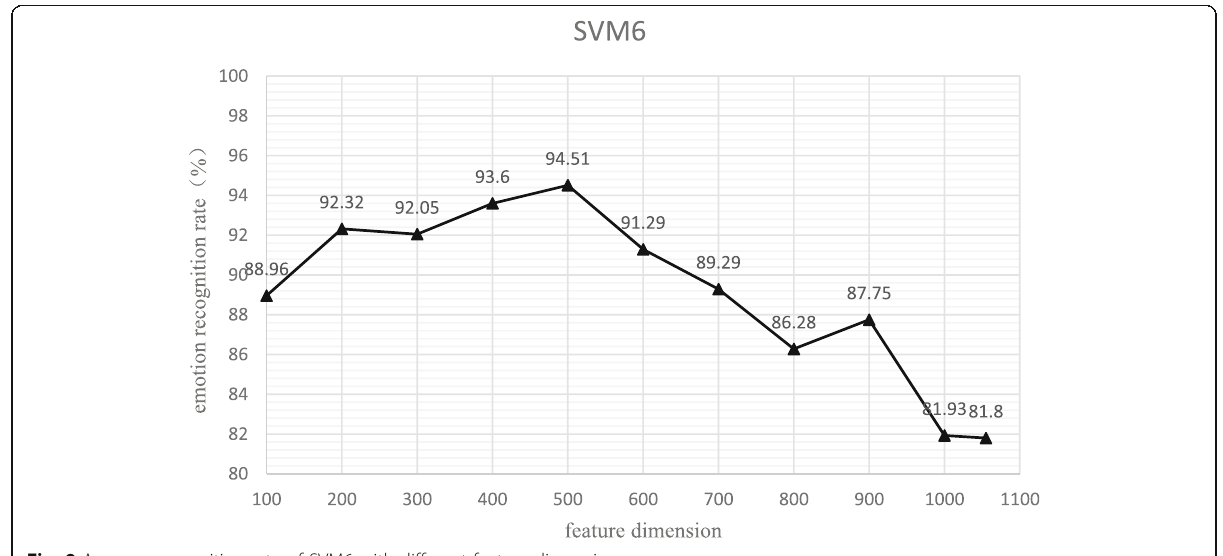
Fig. 9 Average recognition rate of SVM6 with different feature dimensions